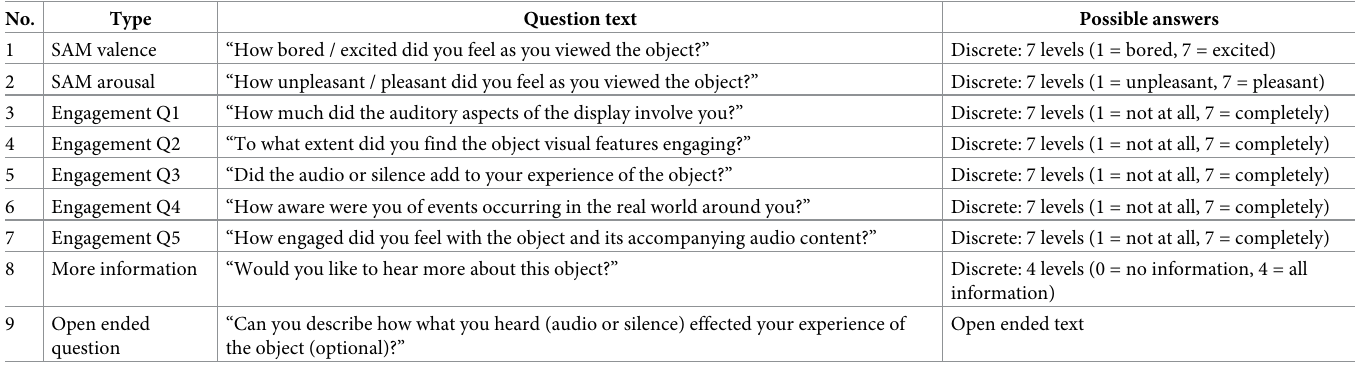
Table 1. The question bank presented to participants after each